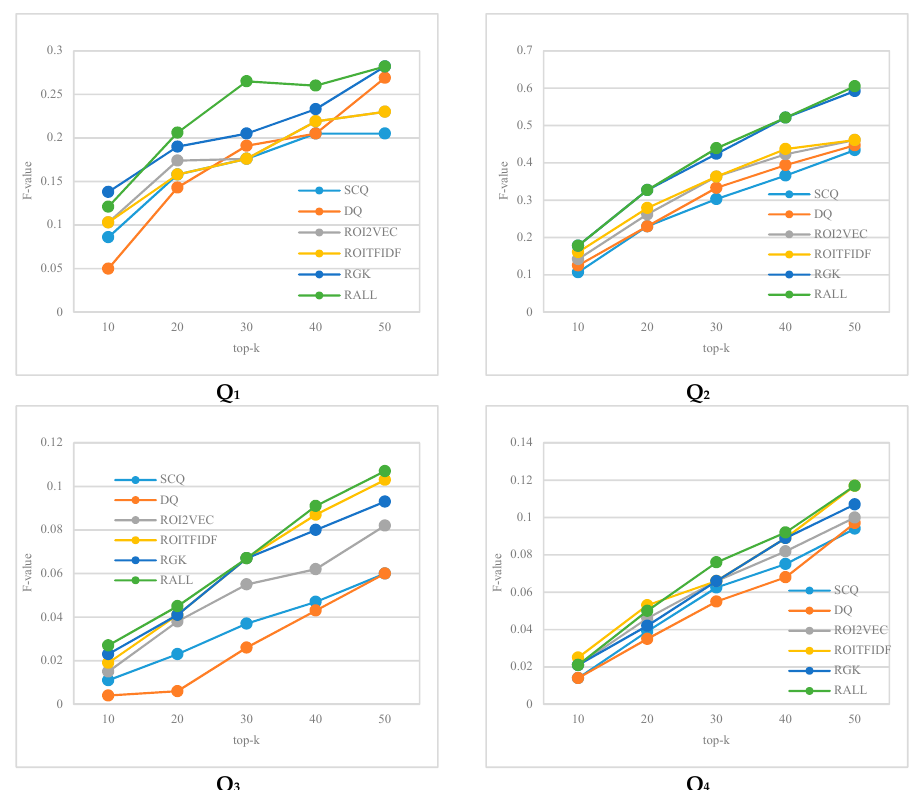
Figure 9. The performance comparison of the methods in Q1~Q4, which shows the change of the F-values (y-axis) of the query results with increases in the K value of the top-K query (x-axis).